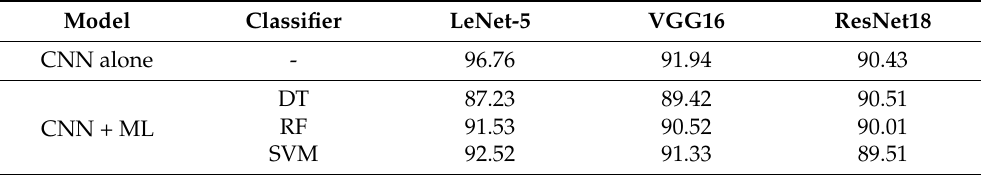
Table 3. Overall accuracy (%) of the two classification strategies.